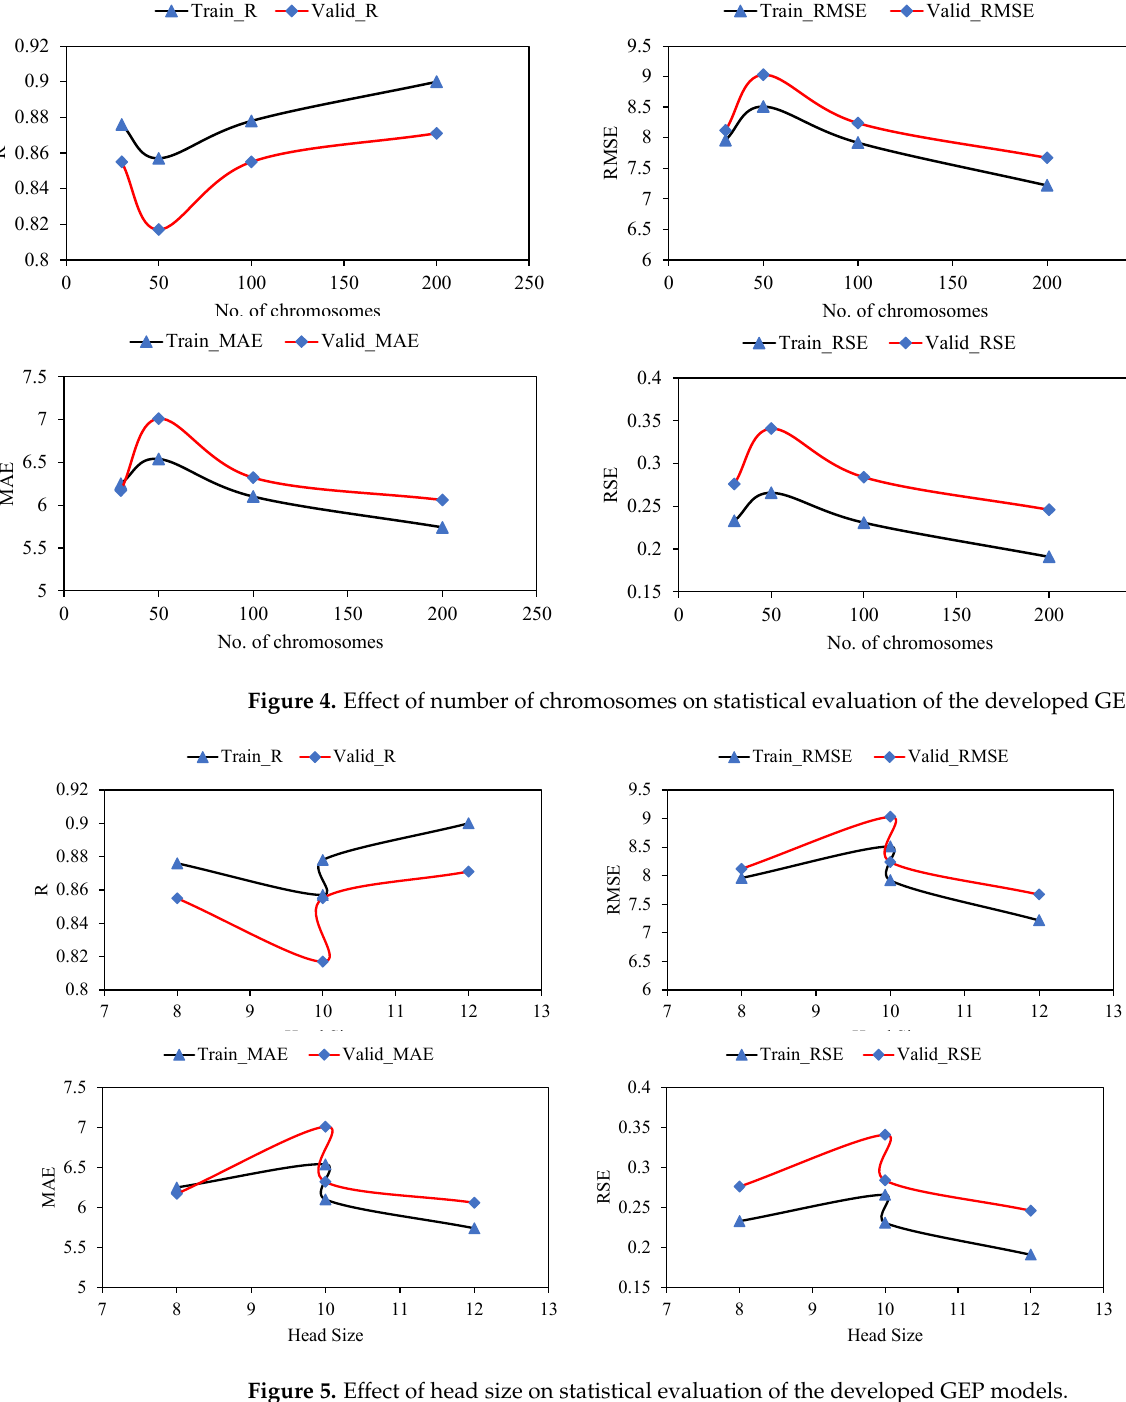
Figure 6. Effect of number of genes on statistical evaluation of the developed GEP models.